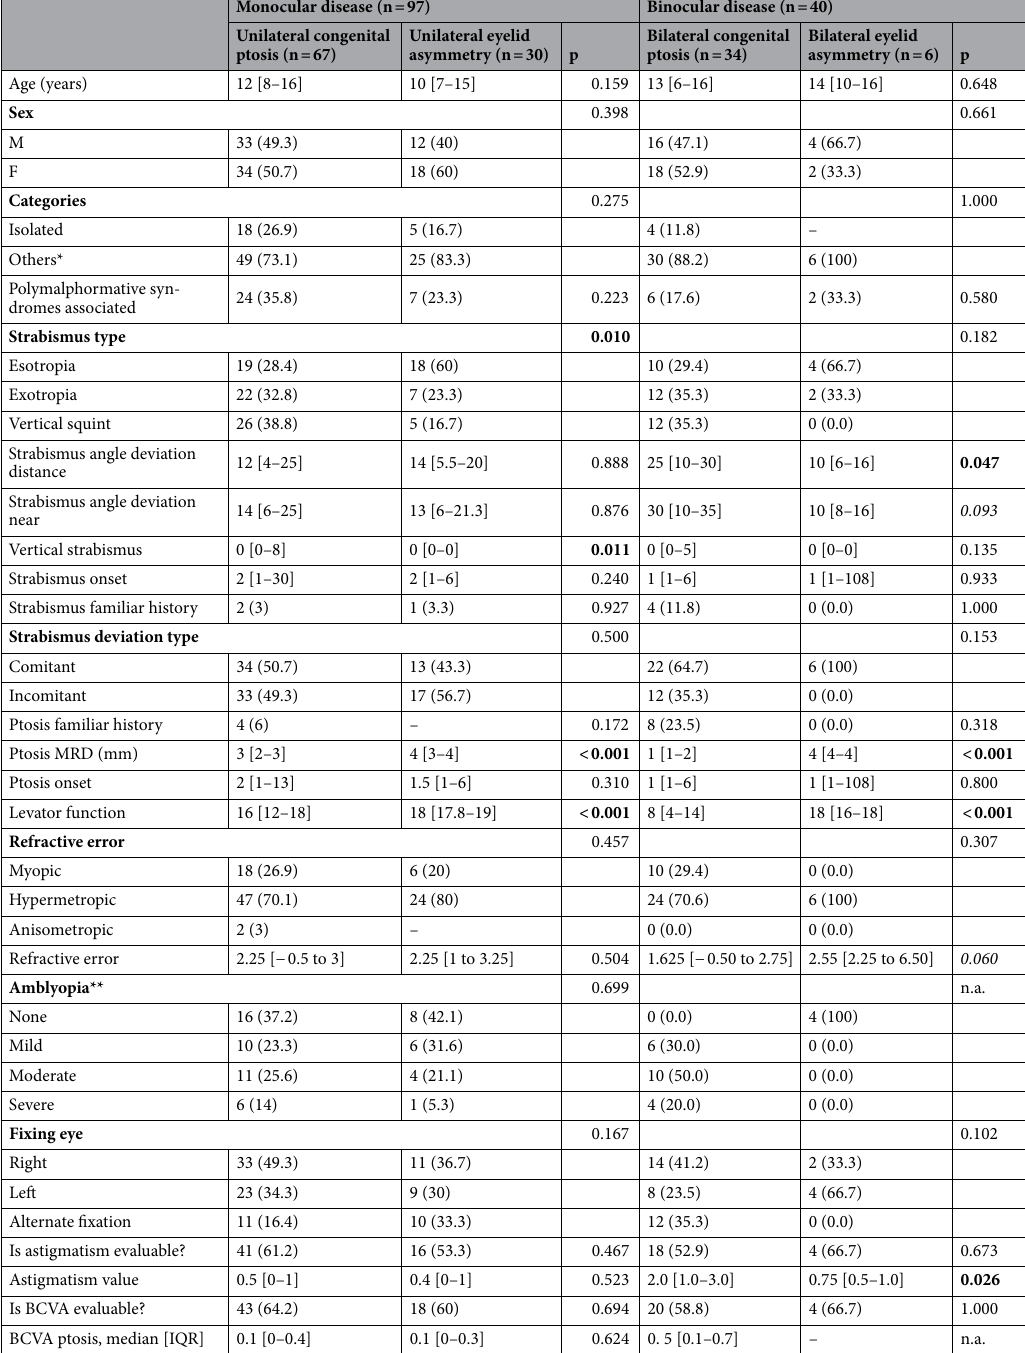
Table 3. Association between ptosis features and general and clinical characteristics in the study cohort, according to patients’ subgroups (n = 137). M male, F female, MRD margin reflex distance, BCVA